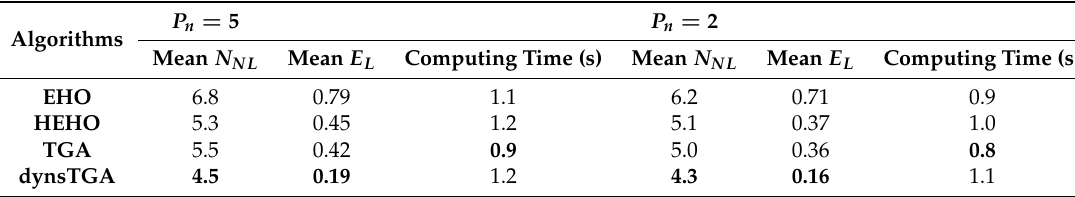
Table 5. Simulation results for M = 40, N = 8 and the search domain area 100 U × 100 U with different values for P n averaged in 30 runs—comparative analysis between EHO, HEHO, TGA, and dynsTGA (best results for each performance indicator are marked